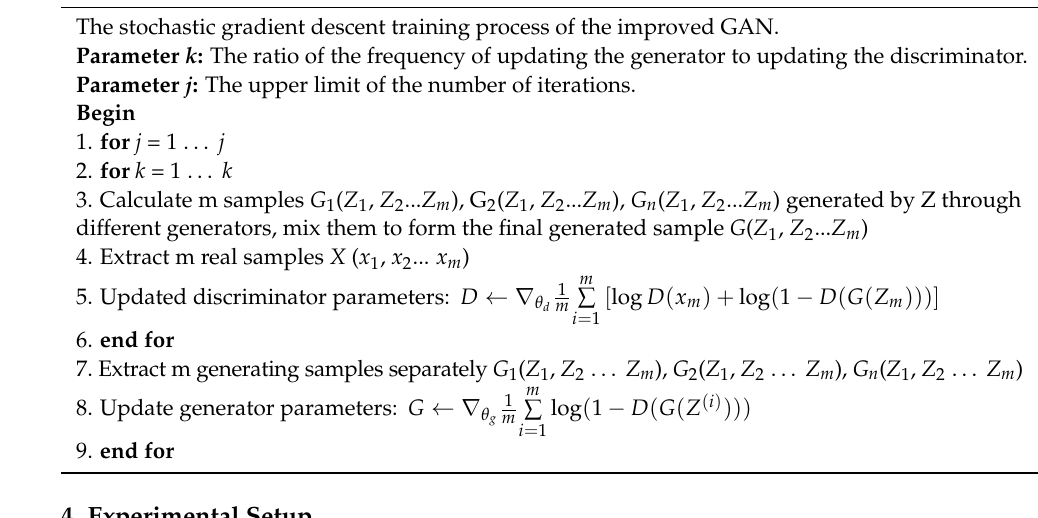
Algorithm 1. Traffic Data Generation